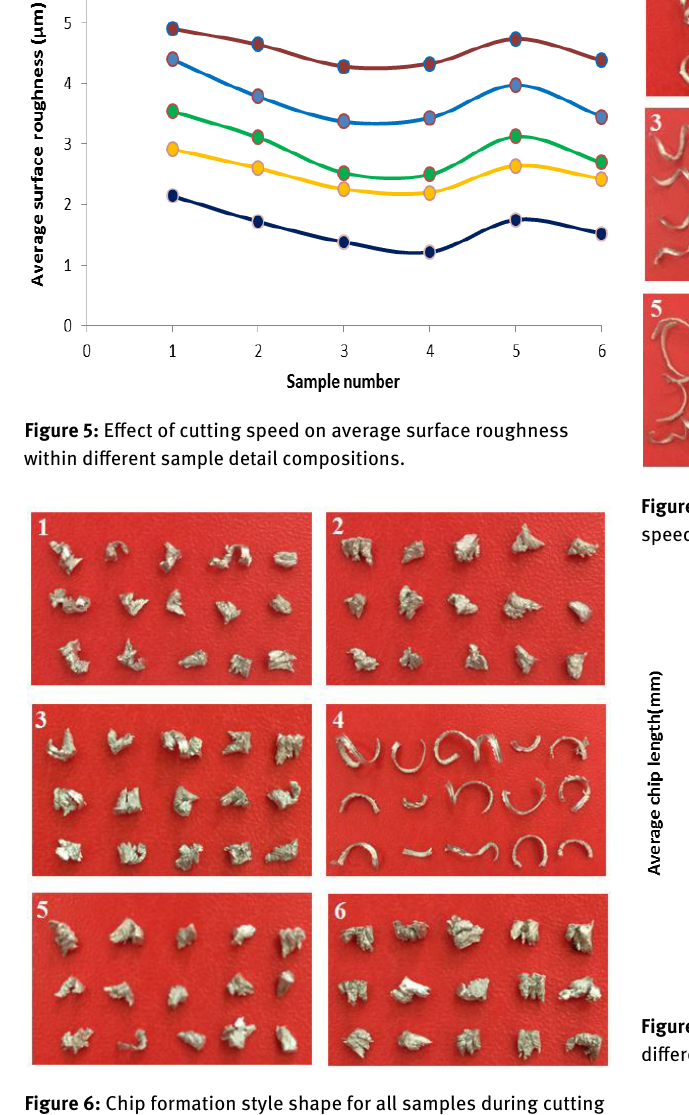
Figure 6: Chip formation style shape for all samples during cutting speed of 10 m/min.